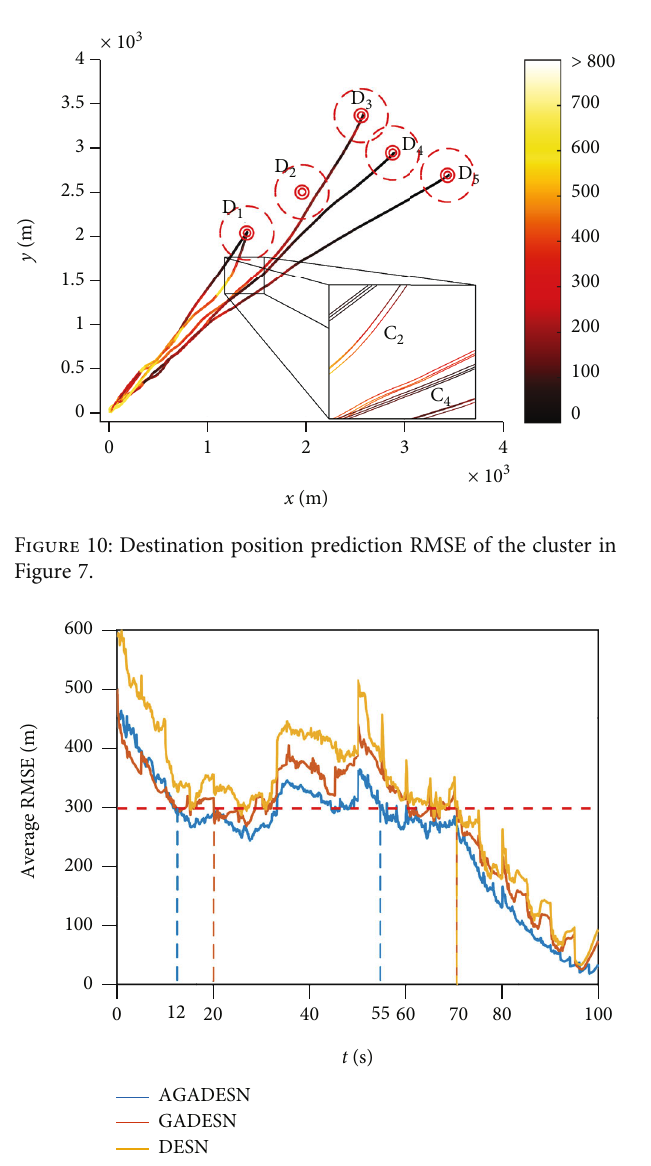
Figure 11: Average RMSE of destination position prediction for all cluster in the test set.